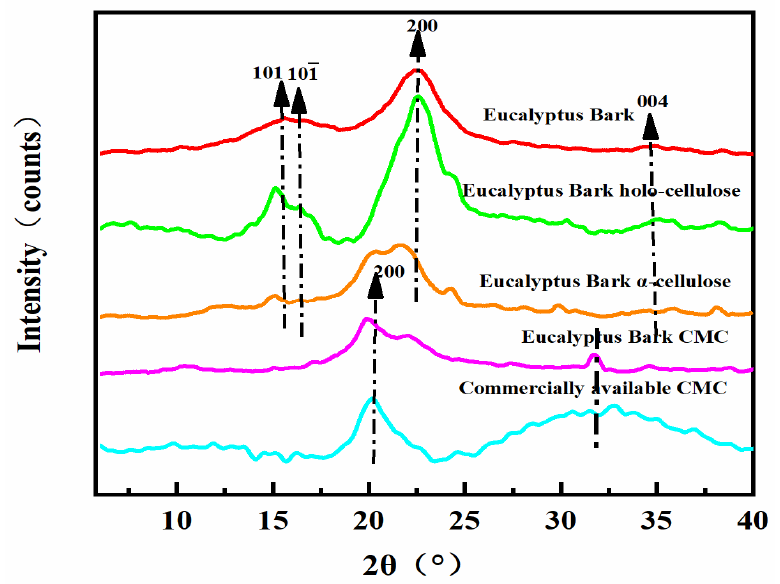
Figure 4. XRD diffractogram showing bark, holo-cellulose, cellulose, and CMC from eucalyptus bark, as well as commercially available CMC.